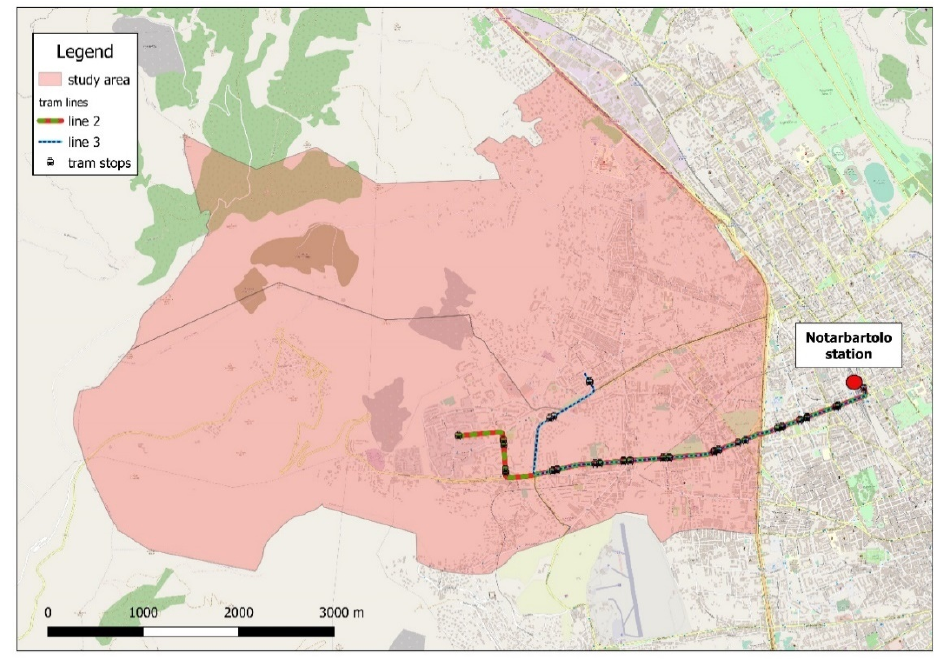
Figure 3. The tram lines in the study area.